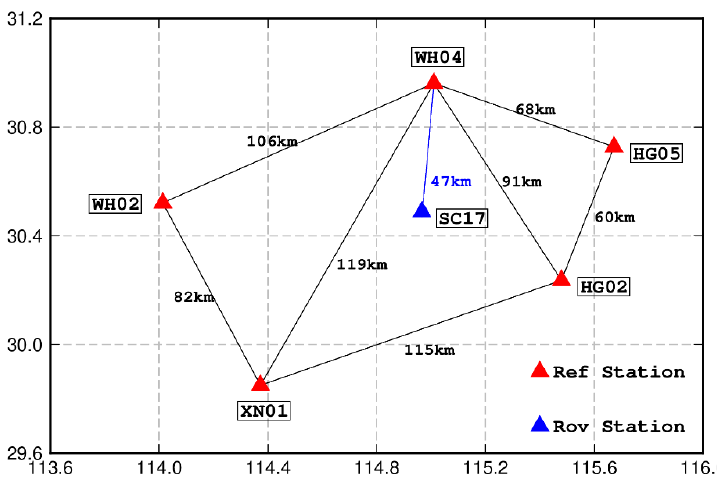
Figure 2. Distribution of the reference stations (red triangles) and rover stations (blue triangles).